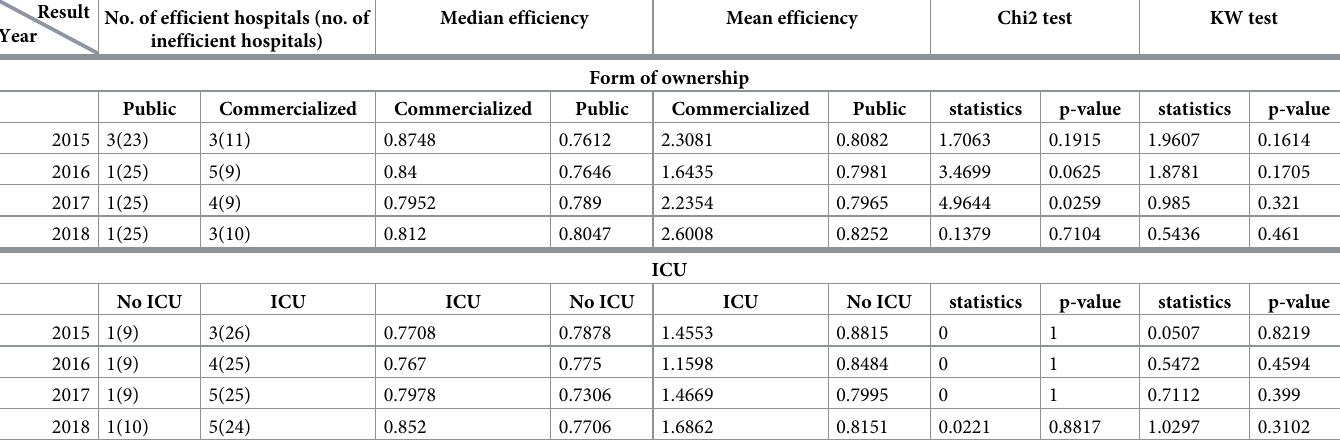
Table 12. Efficiency of hospitals without ED with respect to the form of ownership and ICU ( traditional